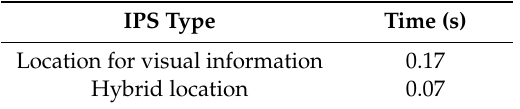
Table 4. Relation of the time factor and the use of